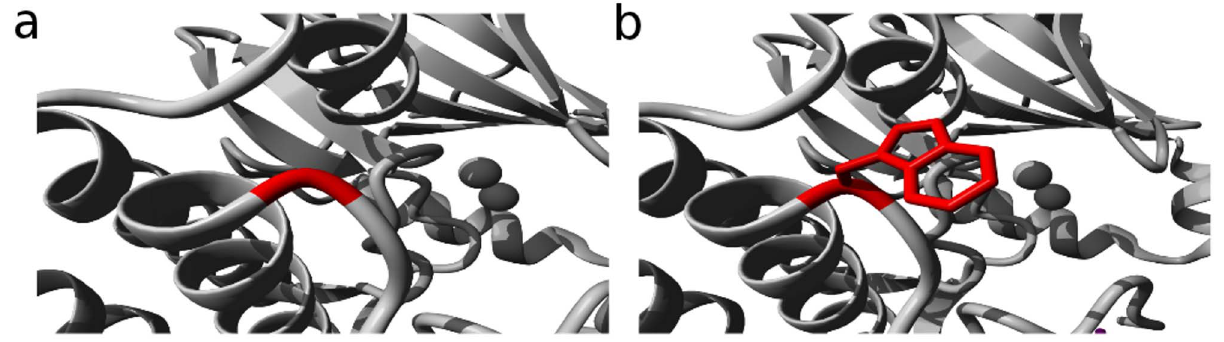
Figure 1. Location of the mutant residue. a) Native Aurora-A protein b) Mutant Aurora-A protein. The mutant location is shown in red.